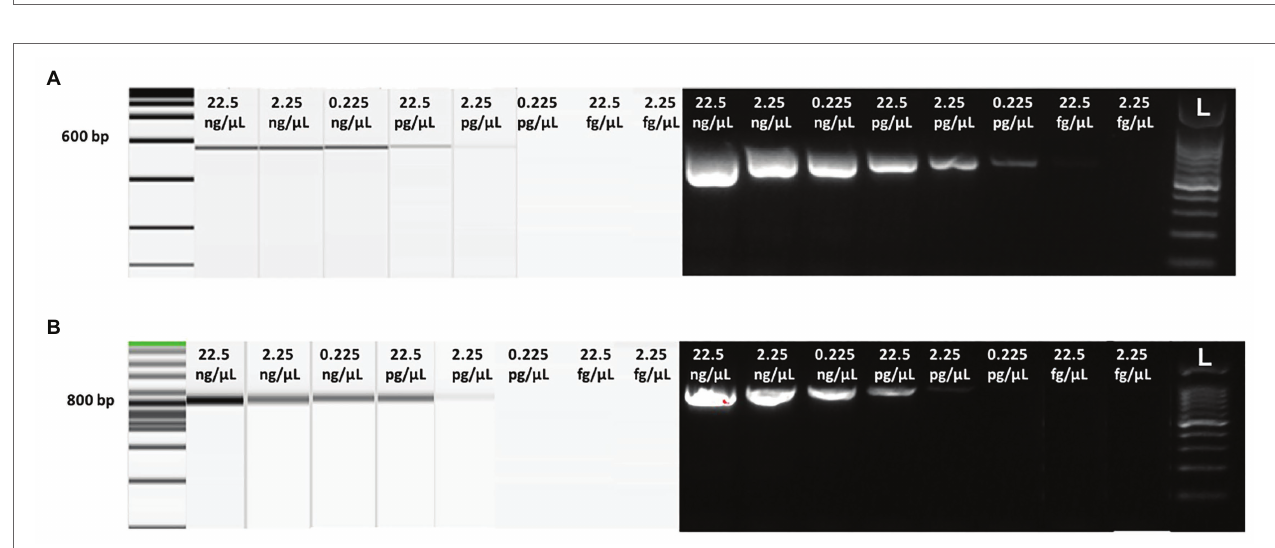
FIGURE 4 | Analytical sensitivity of the Visual RT-LAMP based on the HNB colorimetric assay showing the relative reaction tubes: purple color indicates negative samples, while blue color indicates the positive ones. For each reaction tube, the corresponding agarose gel is shown above. L = 100 bp DNA Ladder (GeneSpin).